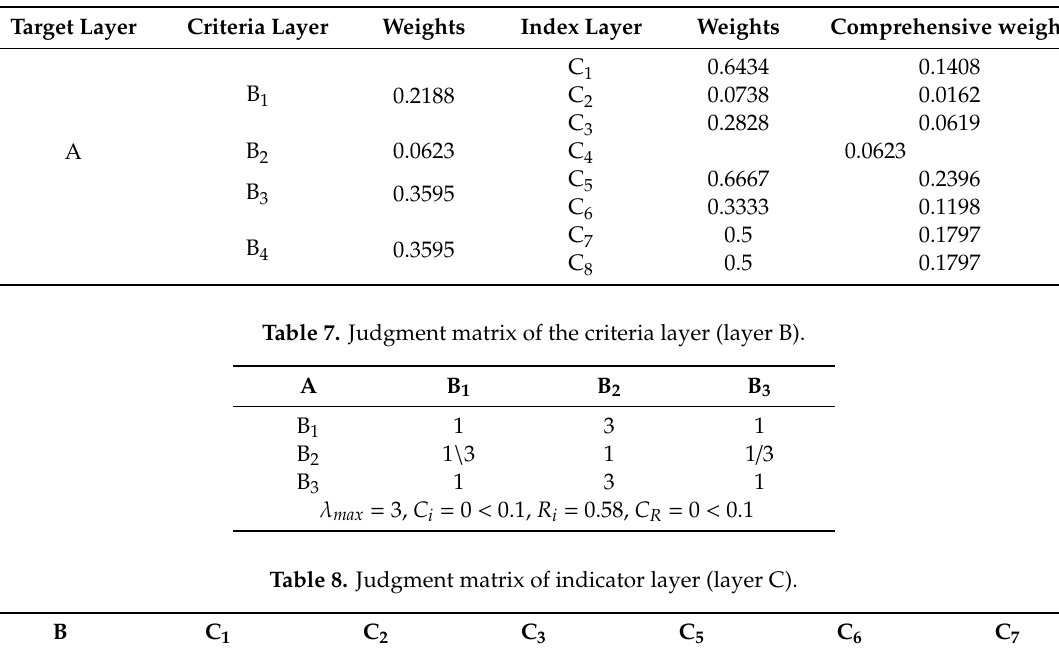
Table 6. Weight table of geological environment bearing capacity evaluation system.